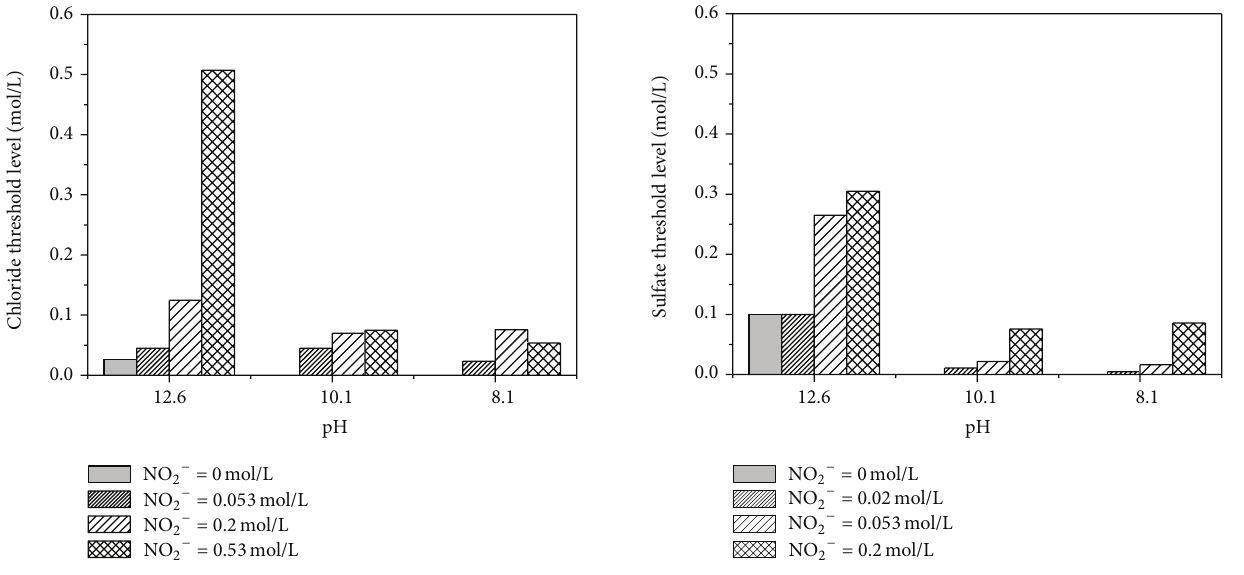
Figure 10: Effect of NO 2− on the threshold values of Cl − . Figure 11: Effect of NO 2− on the threshold values of SO 42−